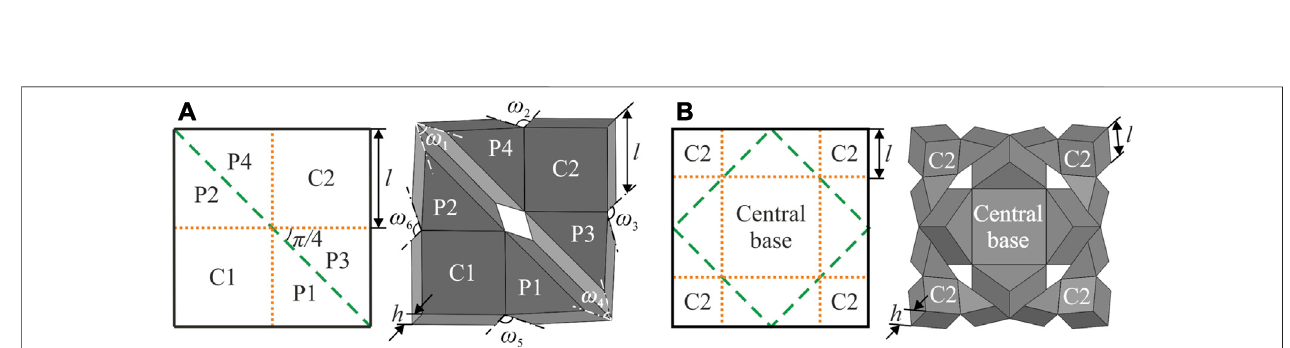
FIGURE 1 | The robotic gripper based on the thick panel waterbomb origami. (A) Bottom view of the gripper with four fi ngers semi-closed. (B) Side view of a grasping test on an egg.